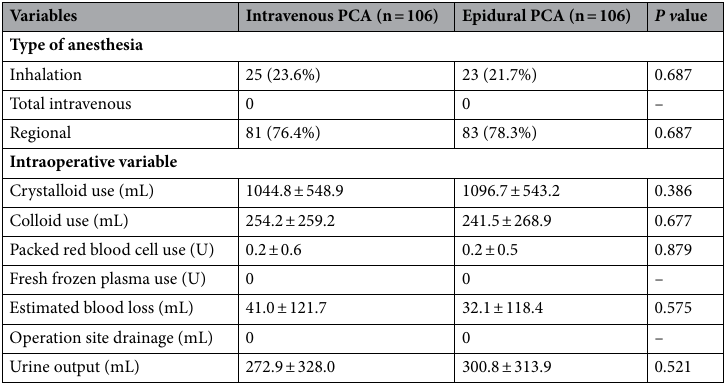
Table 5. Intraoperative variables between the intravenous PCA and epidural PCA groups: PS-matched data. Data are presented as mean ± standard deviation or number (%), as appropriate. PS propensity score, PCA patient-controlled analgesia.